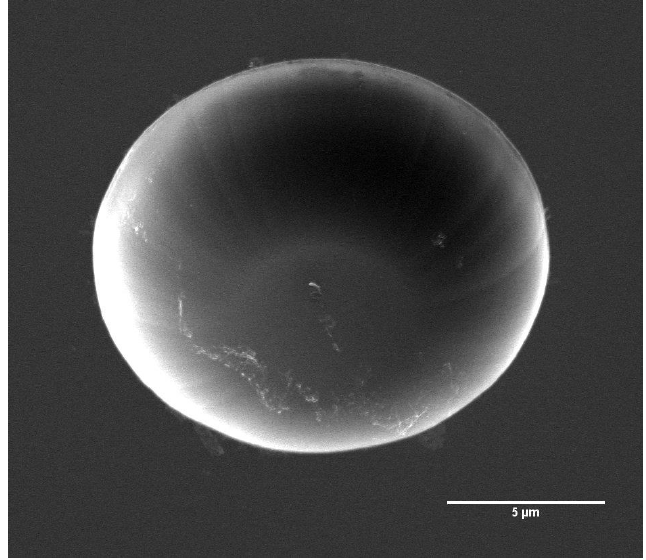
Figure S3. A scanning electron microscope (SEM) image of a microchamber. Figure A3. A scanning electron microscope (SEM) image of a